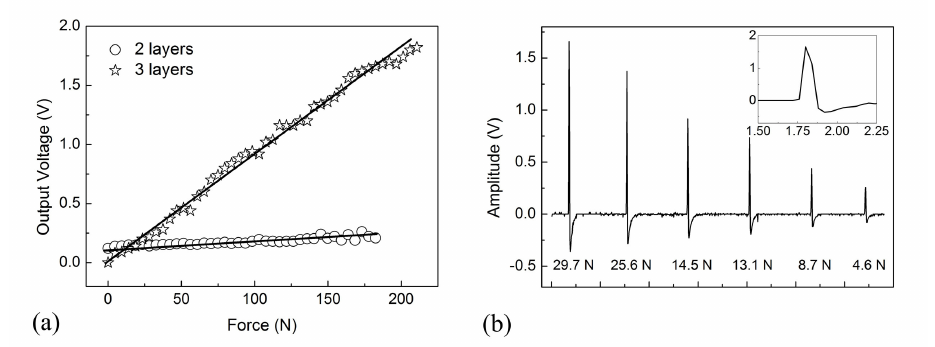
Figure 5. ( a ) Changes of output voltage as a function of stepped load for the designed graphene textile pressure sensor. ( b ) The output changes of the sensor at different loading values. The insert showed the waveform at a load of 29.7